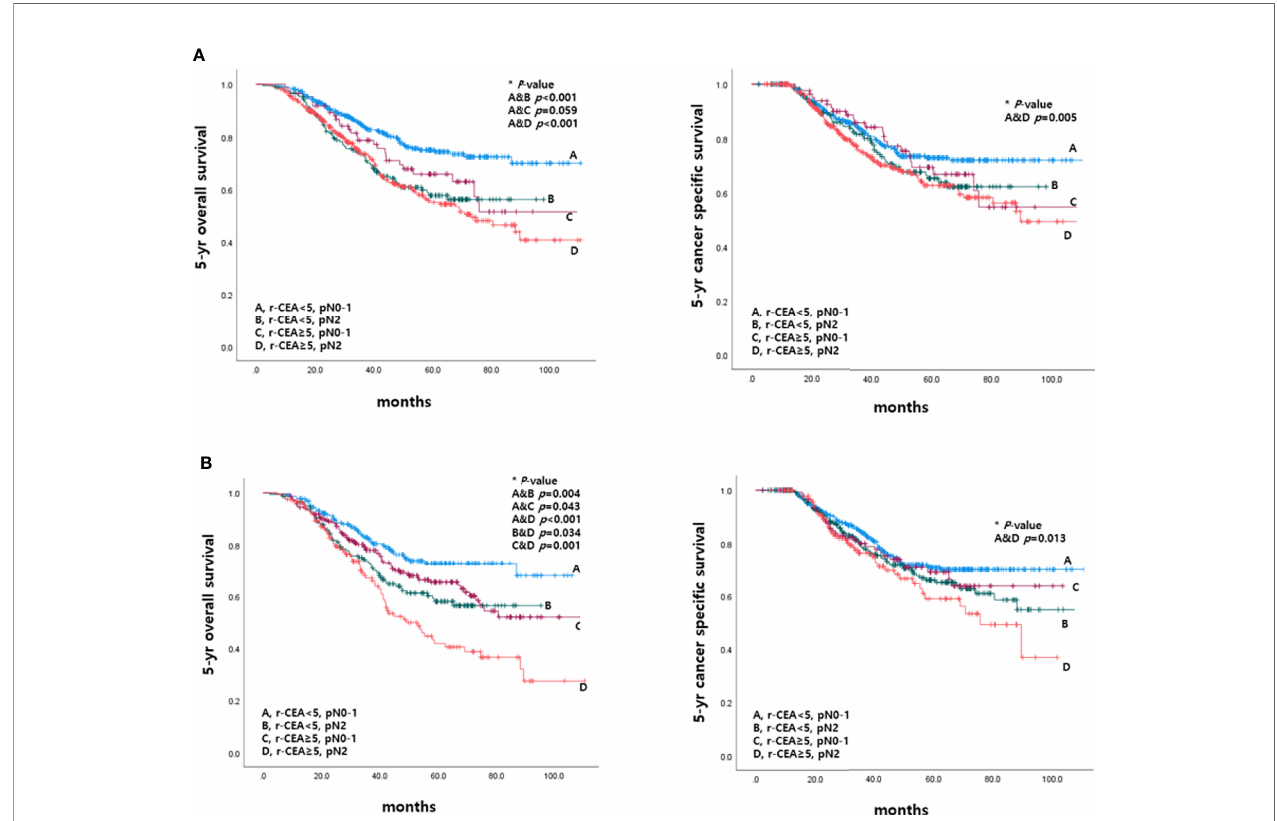
FIGURE 6 | Survival according to CEA level at the time of recurrence and pathologic nodal status before and after matching. (A) Before matching. (B) After